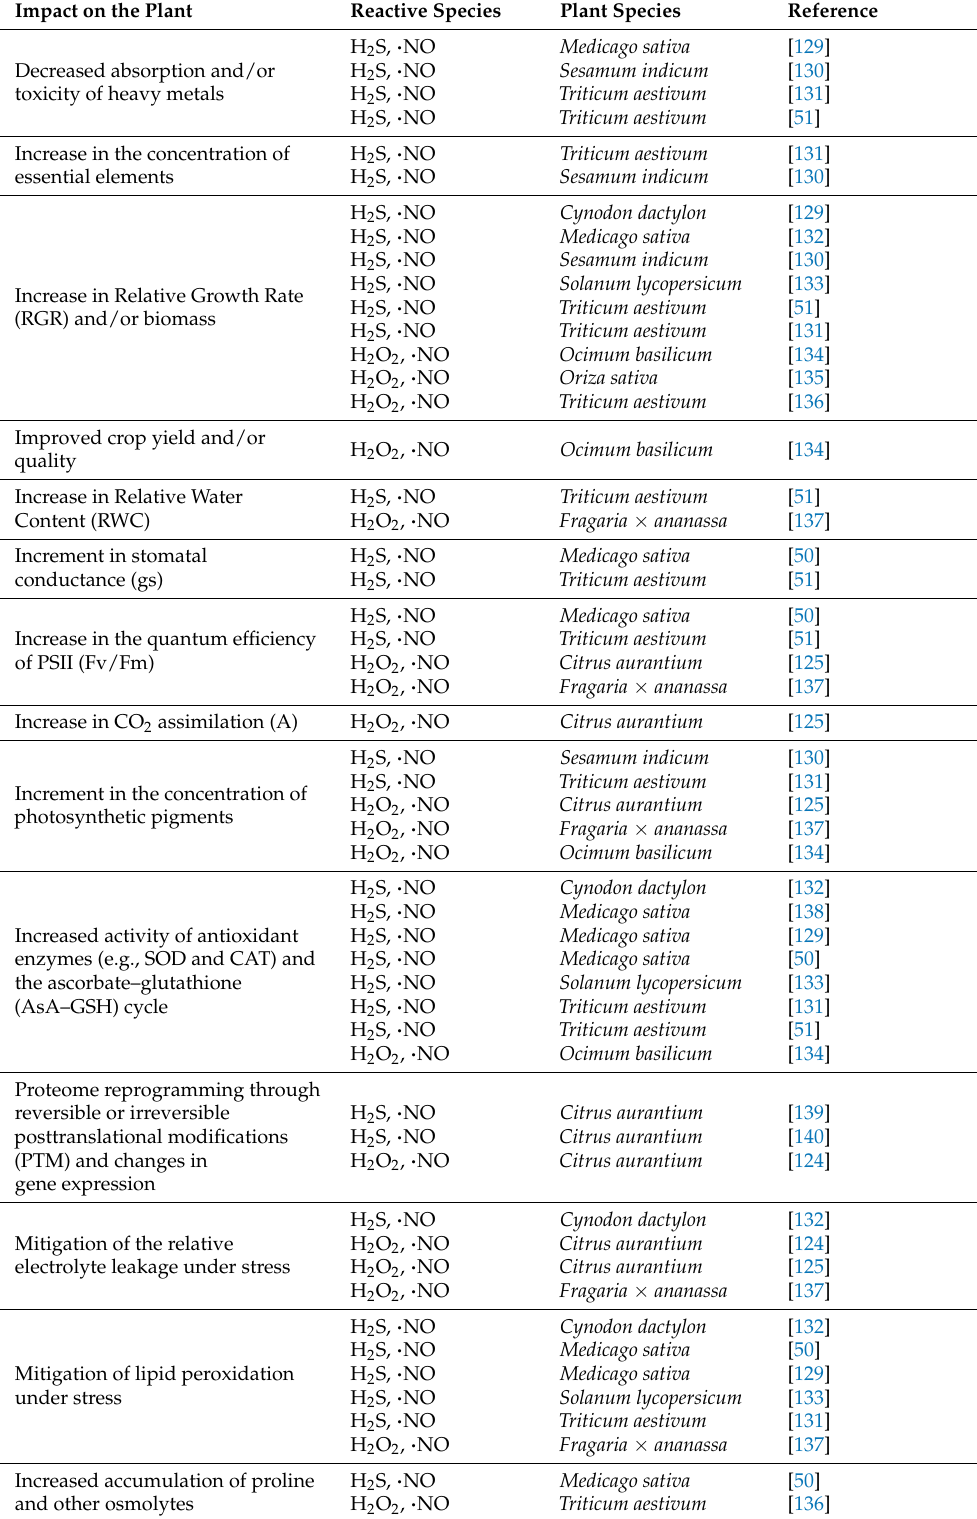
Table 4. Some examples of studies where the favorable impact of applying at least two of the reactive species: ROS, RNS, and RSS or their precursors in plants has been